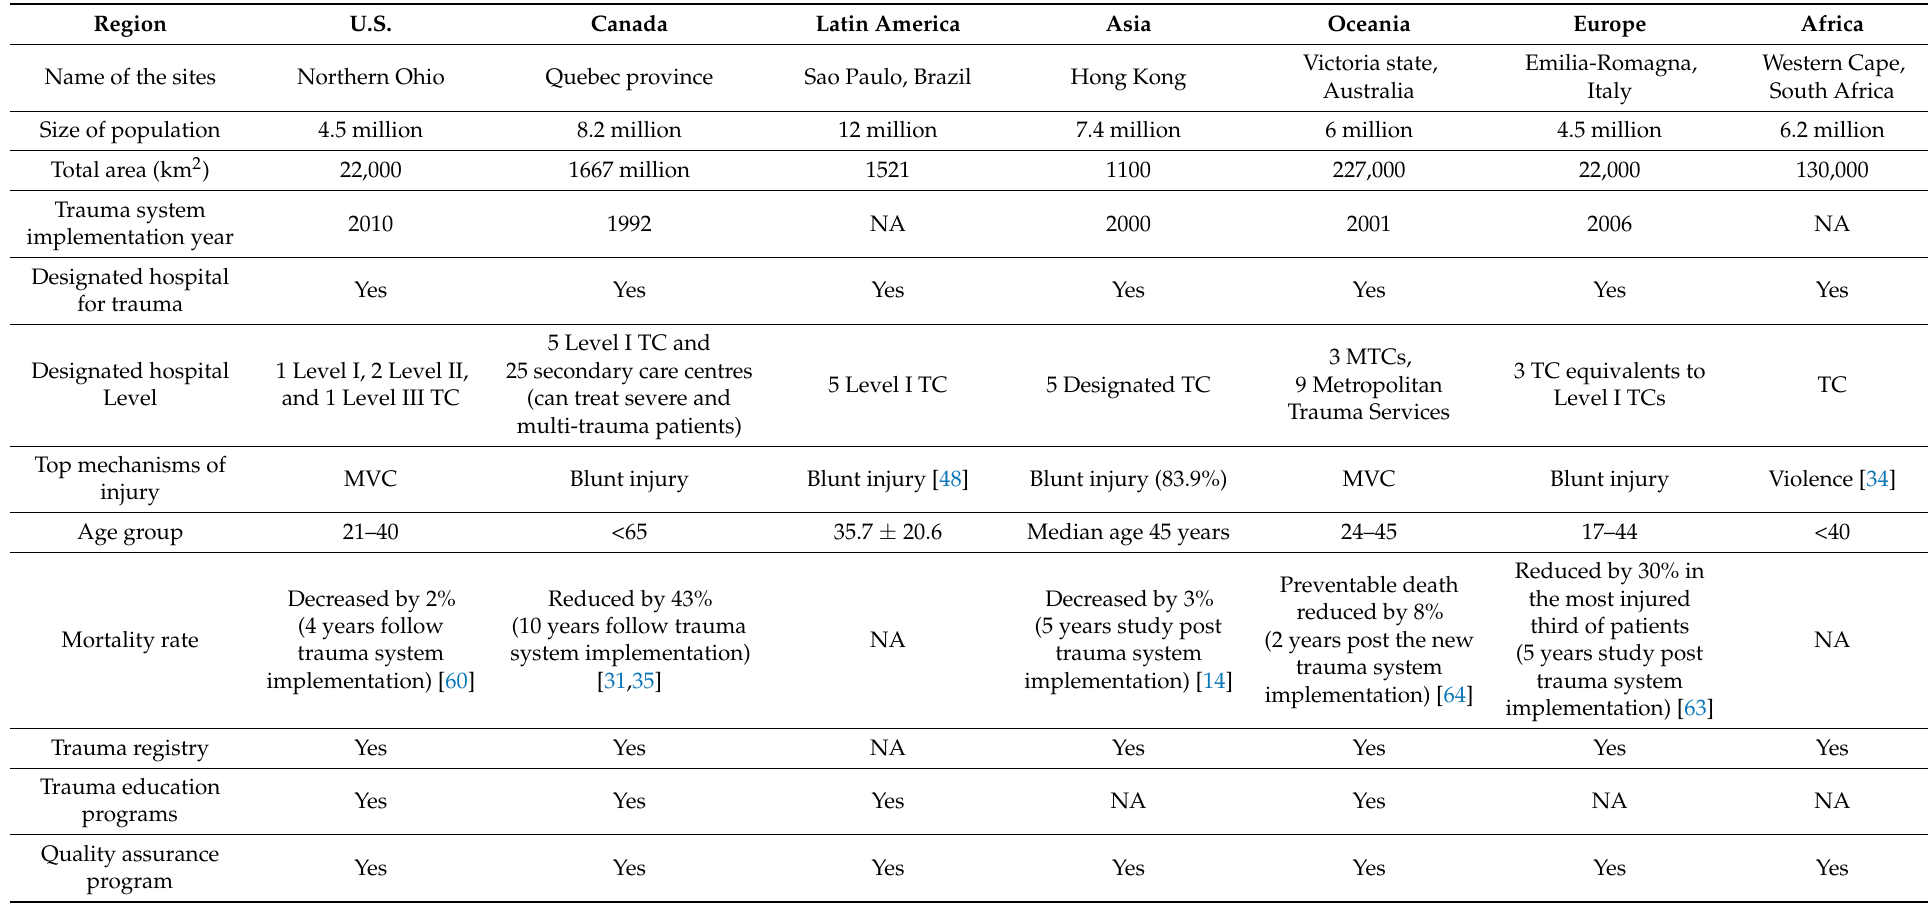
Table 5. Characteristics of hospital trauma care system examples across the seven regions (from refereed literature and example Annual Reports). Region